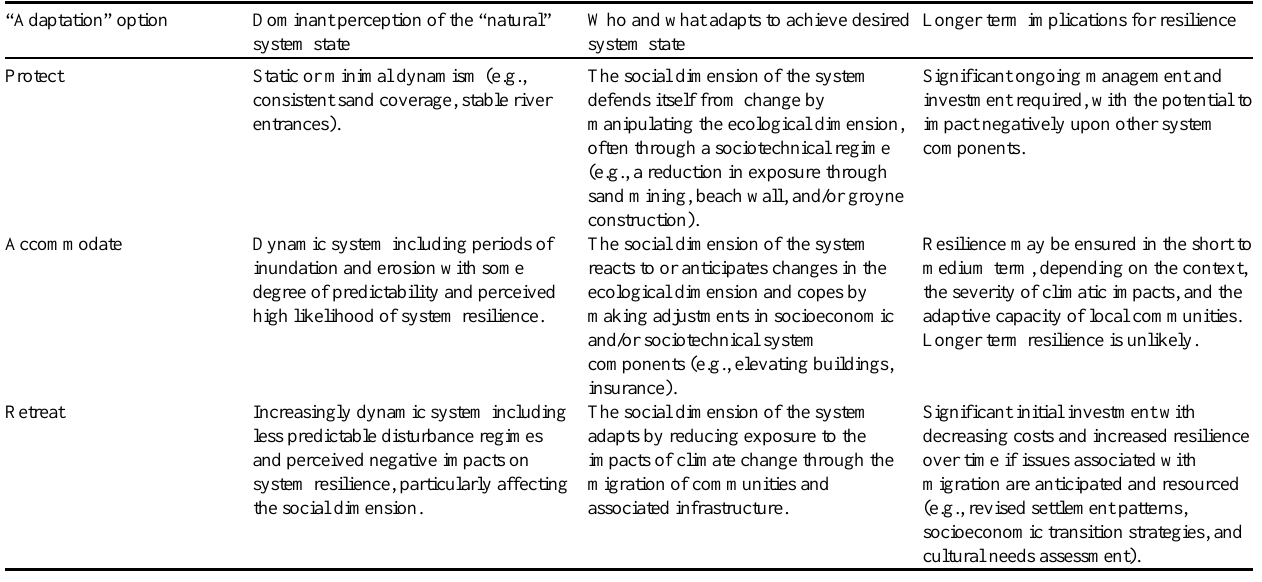
Table 1. Comparison of protect, accommodate, and retreat options “Adaptation”